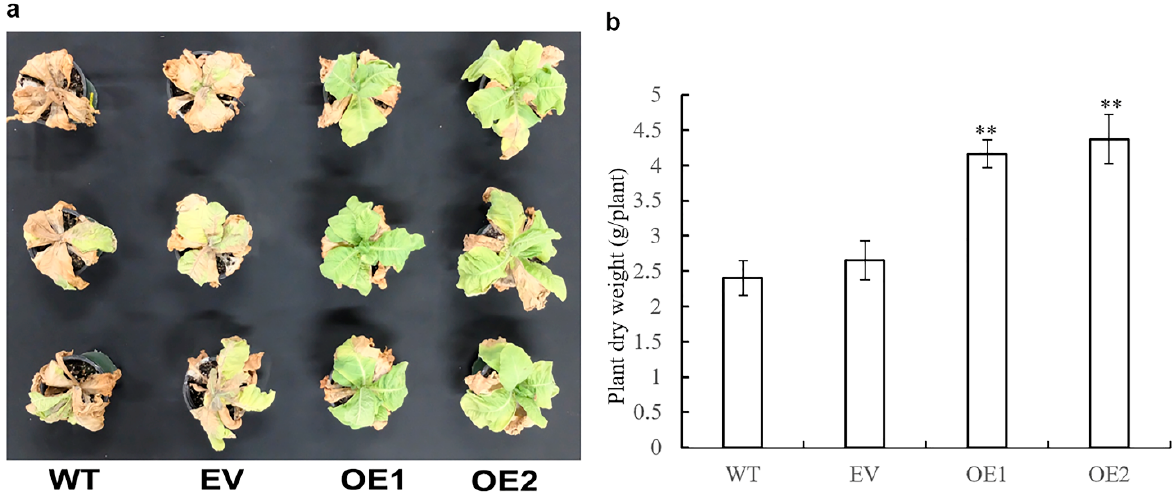
Figure 6. Responses of the AaPEPC1 -overexpressing tobacco plants under salt stress. ( a ) Phenotypes of transgenic plants expressing AaPEPC1 (OE1, OE2) or empty vector (EV), and wild-type plants (WT) grown in pots under 200 mM NaCl stress. The plants were irrigated with 200 mM NaCl solution once every 2 days for 4 weeks. ( b ) Dry weight of transgenic plants and WT. Values represent means ± SD (n = 3). ** significant difference from that of WT p < 0.01, by one-way ANOVA analysis with post-hoc Tukey HSD. Cells 2021 , 10 , x FOR PEER REVIEW